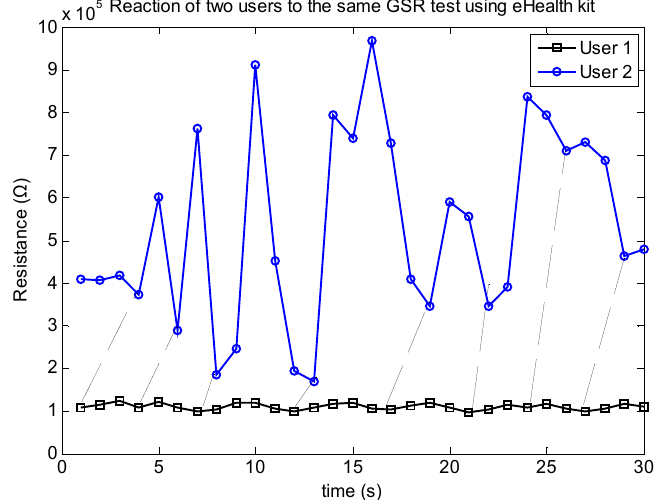
Figure 10. Comparison of two identical Libelium GSR sensors attached to different users that are subject to the same test. The vertical dashed lines denote the corresponding local minima between the two users.